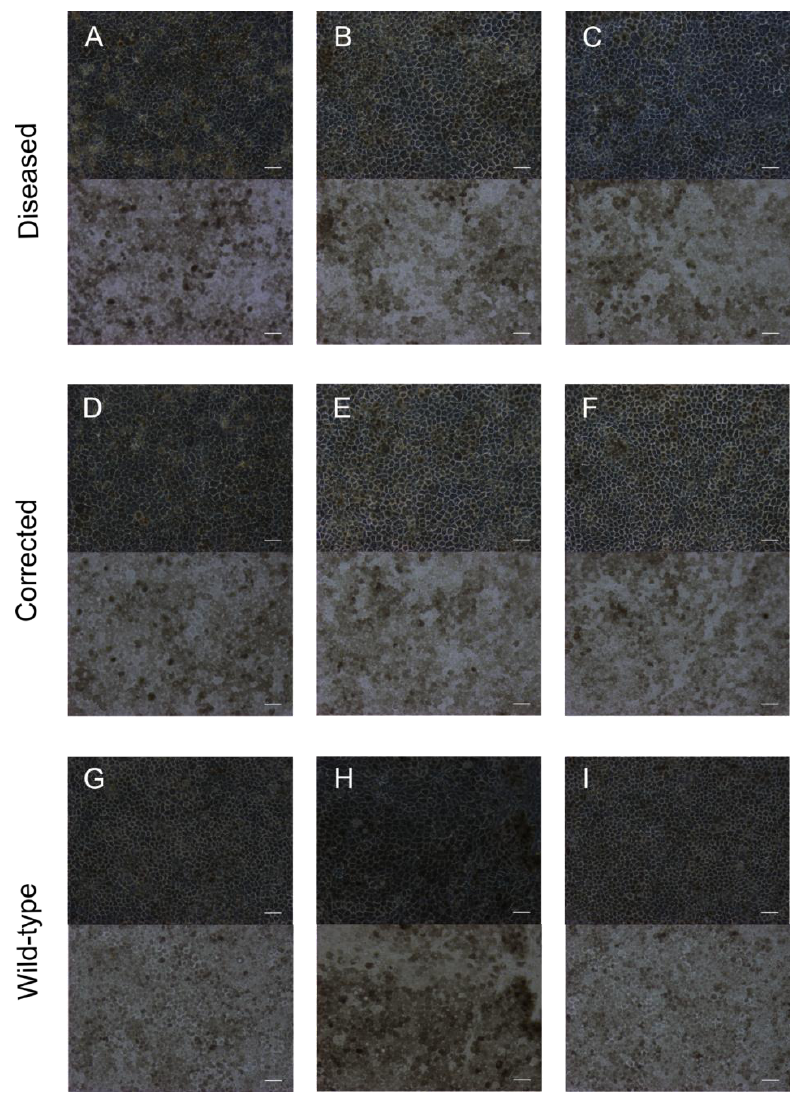
Figure 1. Polygonal morphology and pigmentation at passage 3 on day 30, Fully matured RPE cells exhibit polygonal morphology as observed by phase contrast (20× objective, top images) and pigmentation as observed by bright field microscopy (20X objective, bottom images): ( a – c ) iPSC-RPE cells derived from 3 separate patient clones; ( d – f ) iPSC-RPE cells derived from three separate patient clones with gene correction; ( g ) H9 embryonic stem-cell-derived RPE; ( h ) MyCell iPSC-RPE cells; ( i ) UCSF4 embryonic stem-cell-derived RPE cells. Scale bars are 100 µm.